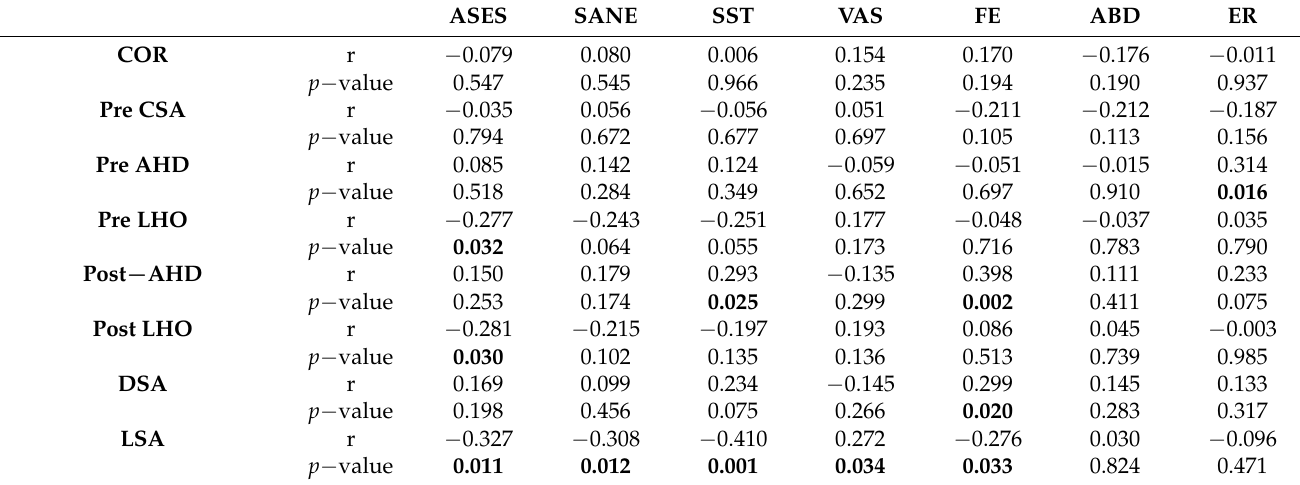
Table A1. Table showing correlation between radiographic analysis and final clinical outcome